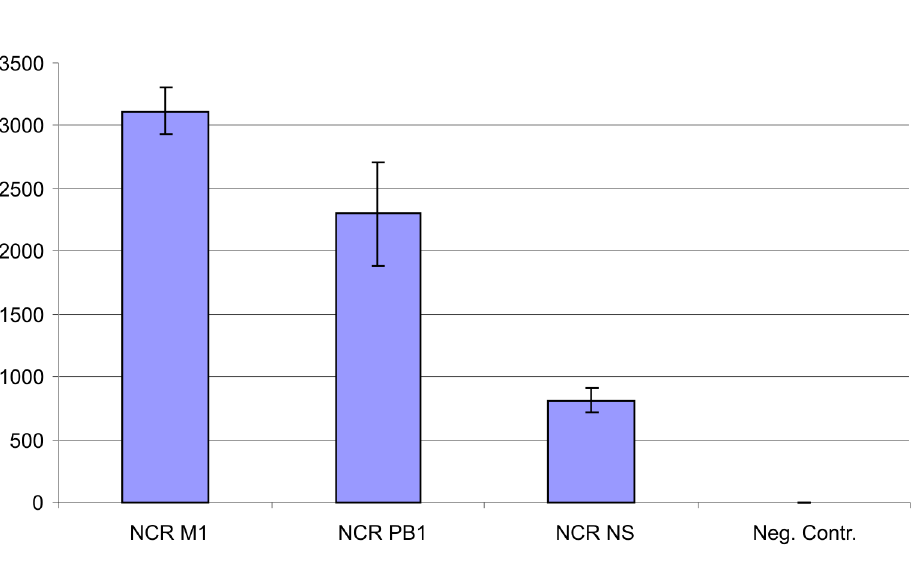
Figure 10. Influence of different NCRs on the expression level . HEK-293 cells were tranfected with the influenza replicon and either pMono- lucNS (NCR NS) or pMono-lucM (NCR M) or pMono-lucPB1 (NCR PB1) or with pMono-lucNS and pBi-NP only (Neg. Contr.). Additionally, pRL, coding for Renilla luciferase, was cotransfected in all cases. Cells were harvested 48 hours post transfection and subjected to luciferase assay. Firefly values have been normalized to Renilla values. Data represents arithmetic mean values and standard deviation.